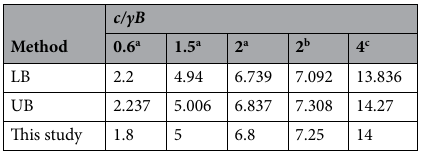
Table 1. Comparison of N c . Note: a represents H/B = 1, α = 45°; b represents H/B = 4, α = 40°; c represents H/B = 4, α =